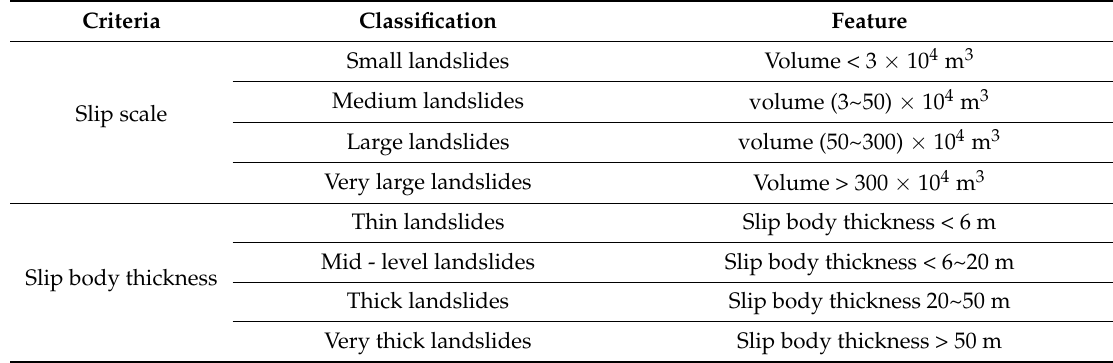
Table 1. Classification of submarine landslides in the northern slope of SCS